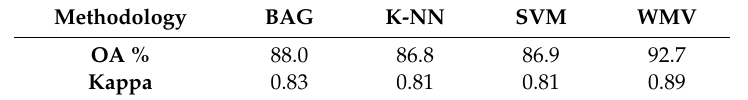
Table 4. The confusion matrix for benthic habitats mapping using WMV method.